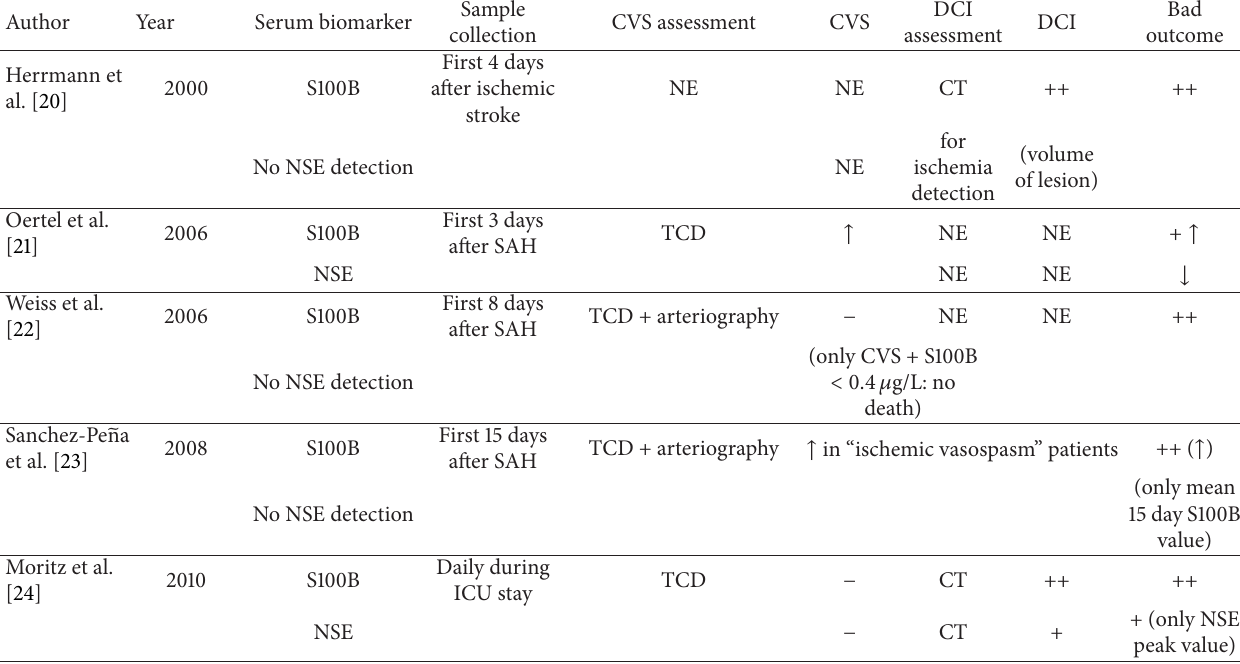
Table 1: Summary of the literature focusing on S100B and NSE as biomarkers after SAH predictive of CVS and/or DCI.